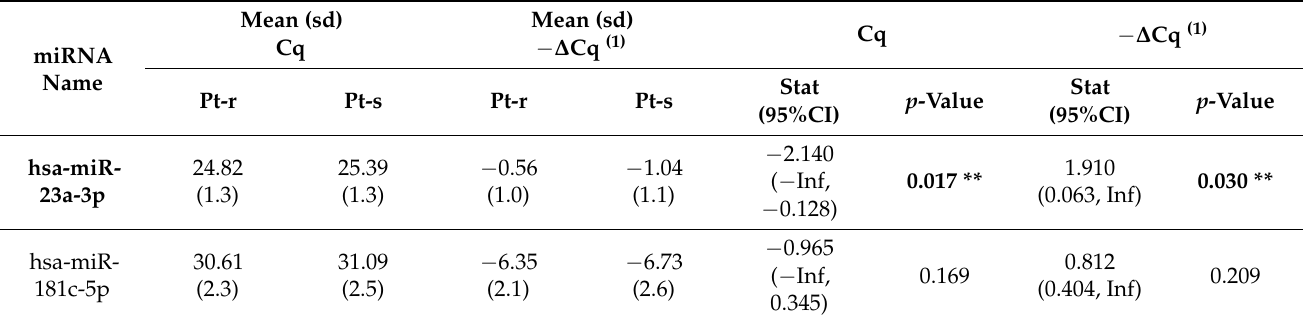
Table 4. Differential expression analysis. The miR-23a-3p and miR-181c-5p expression in Pt-r ( n = 48) and Pt-s ( n = 48) patients evaluated by RT-qPCR (Brescia cohort).